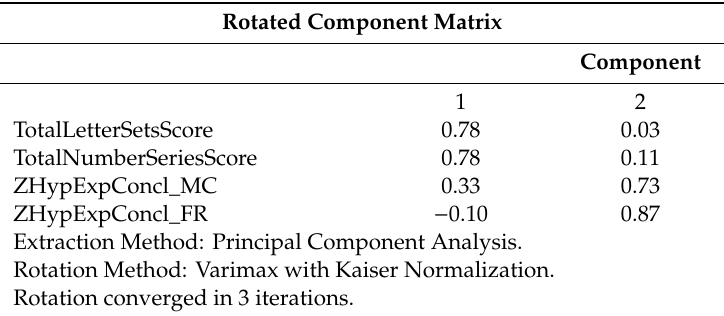
Table 11. Study 2 Rotated Principal-components